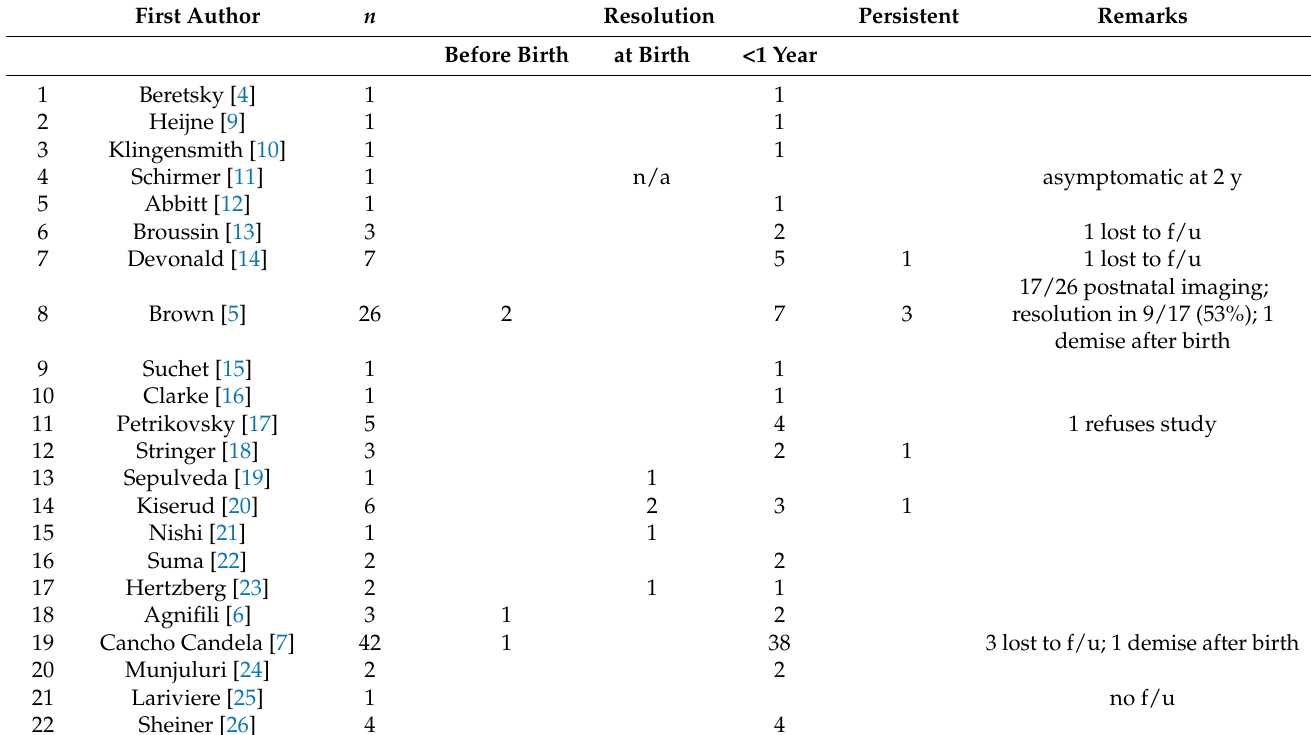
Table 3. Outcomes of newborns with prenatally detected echogenic gallbladder